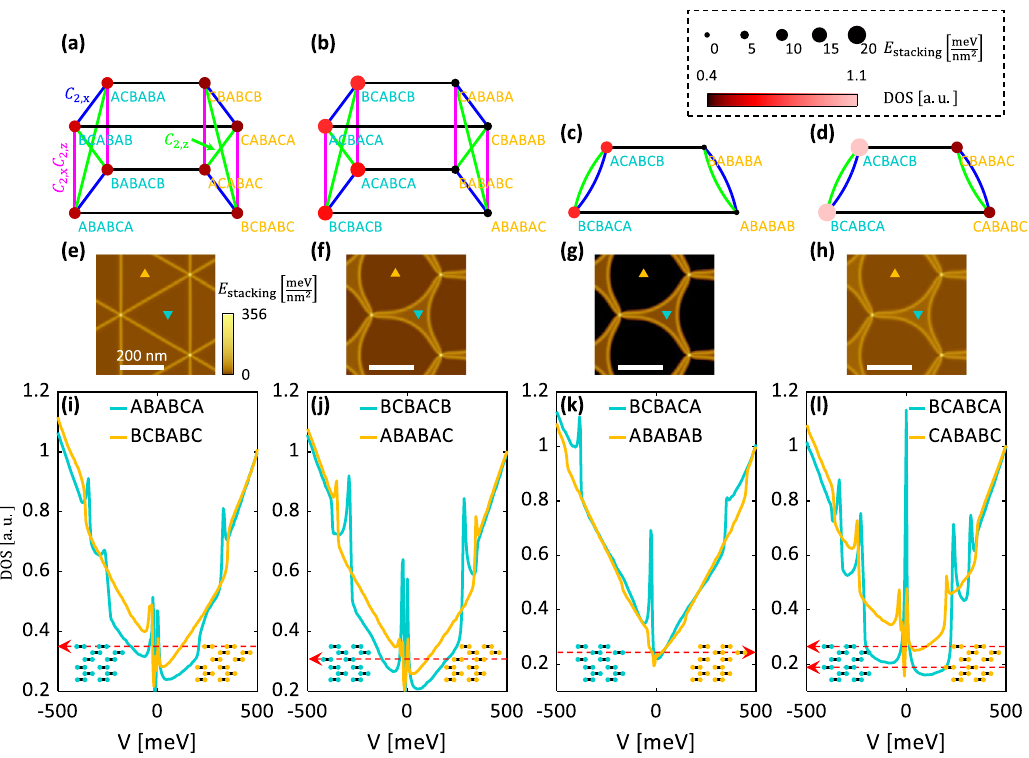
Fig. 3 | Exploration of candidates for TDTG moiré superlattice structures. a – d Each panel addresses a group of con fi gurations. Each moiré pair is connected byahorizontalblackline.Con fi gurationsthatare C 2 symmetrypairsareconnected byblue( C x 2 ),green( C z 2 ),andmagenta( C x 2 C z 2 )lines,respectively.Eachcon fi guration is marked by a circle whose color indicates the low energy spectral weight, and whose size indicates the con fi guration ’ s stacking energy density (see legend). e – h The domain formation is re fl ected by the stacking energy density for a twist angle of 0.04 ∘ for each moiré pair. Each panel is the result of the atomic relaxation calculation (see “ Methods ” ) using the DFT calculated energy imbalance of the